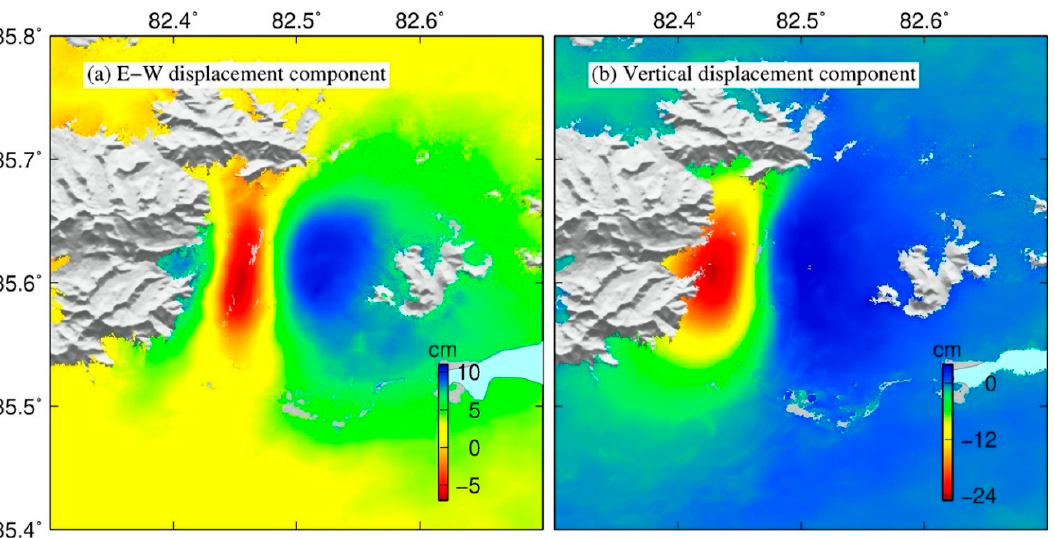
Figure 5. 2.5-D surface displacements caused by the 2020 Yutian earthquake. ( a ) East–west and ( b ) up–down components derived from two Sentinel-1 (tracks T165D and T158A) interferograms in Figure 4.